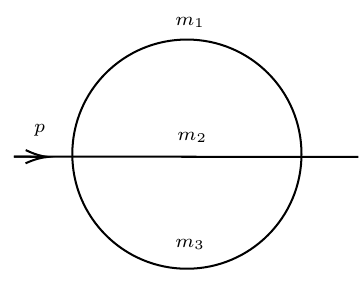
Figure 2 . The three-mass sunrise